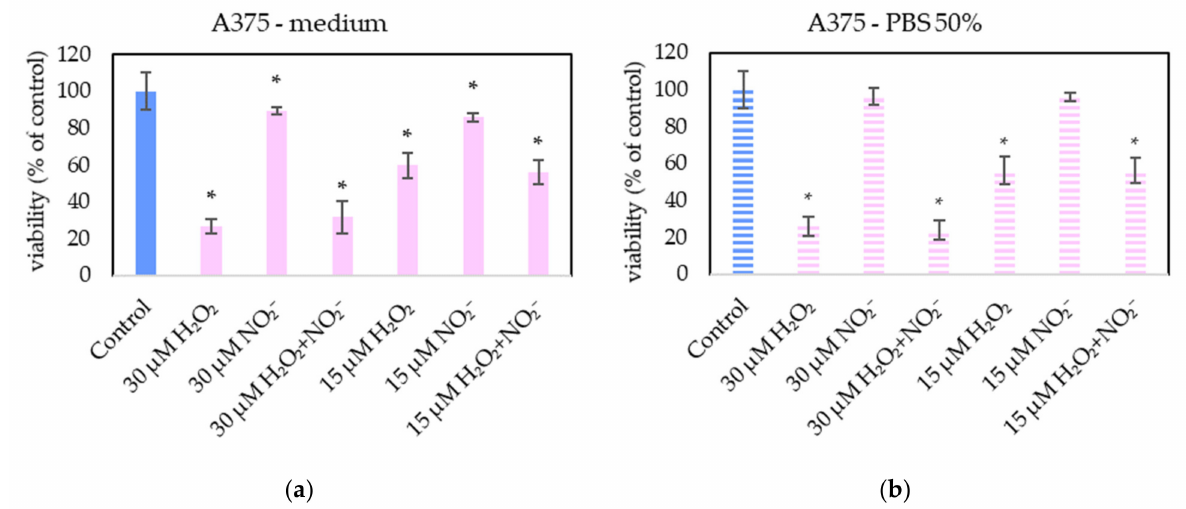
Figure 13. The effect of H 2 O 2 and NO 2 − on A375 cells viability after 24 h incubation. H 2 O 2 and NO 2 − were externally added into 100% medium ( a ) or 50% PBS diluted with medium ( b ). Significance of was tested compared to cells in 100% medium or 50% PBS, no significant difference between only H 2 O 2 and H 2 O 2 + NO 2 − was found. Viability was normalized to the control cells incubated in the medium. The significant results ( p < 0.05) are marked with *.